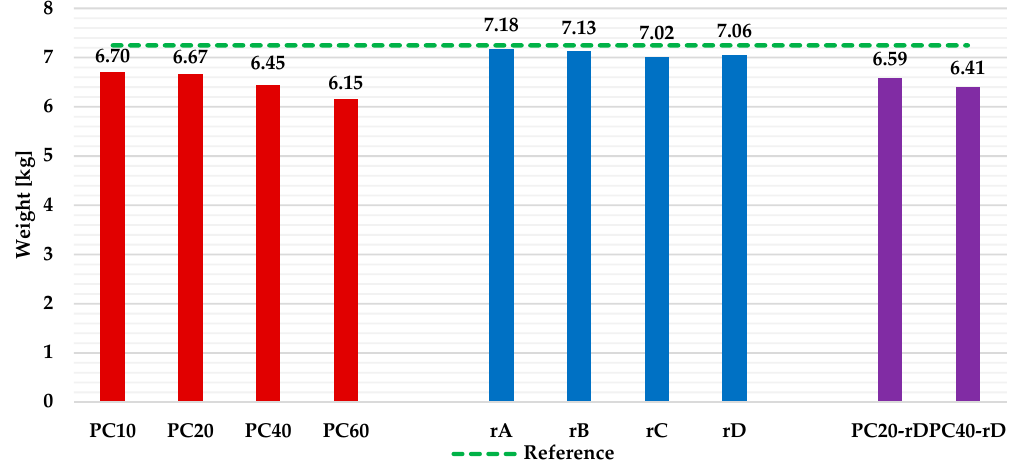
Figure 6. Weight measurement of the plates.